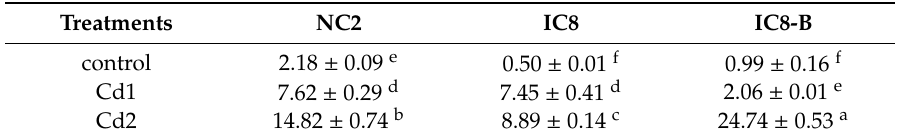
Figure 3. Biomass R / S ratio of chickpea cultivars (NC2, IC8 and IC8-B) exposed to various concentrations of Cd (0, 25 and 50 µ M). The bars represent SE, n = 3. Columns with di ff erent characters are significantly Figure 3. Biomass R/S ratio of chickpea cultivars (NC2, IC8 and IC8-B) exposed to various di ff erent according to (DMRT) at p < 0.05. concentrations of Cd (0, 25 and 50 µM). The bars represent SE, n = 3. Columns with different characters are significantly different according to (DMRT) at p < 0.05. Table 4. Cadmium root / shoot (R / S) ratio of chickpea seedlings grown in a nutrient medium under Cd stress at the rate of 0 µ M (control), 25 µ M (Cd1) and 50 µ M (Cd2) with mean values ± SE, ( n = 3).